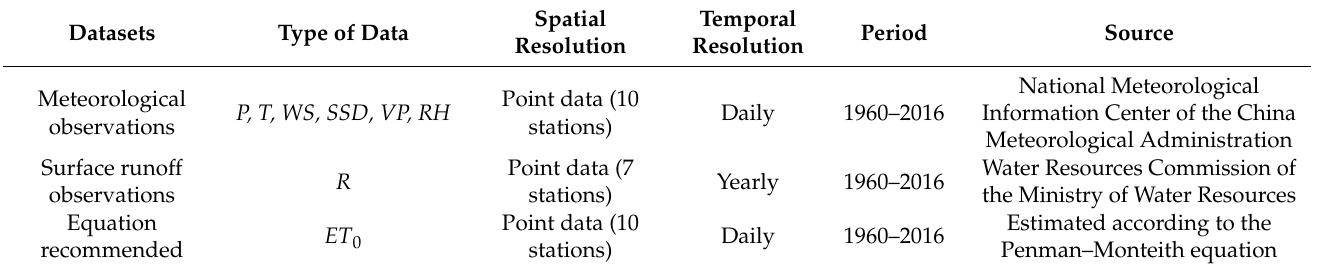
Table 1. Overview of datasets used in this